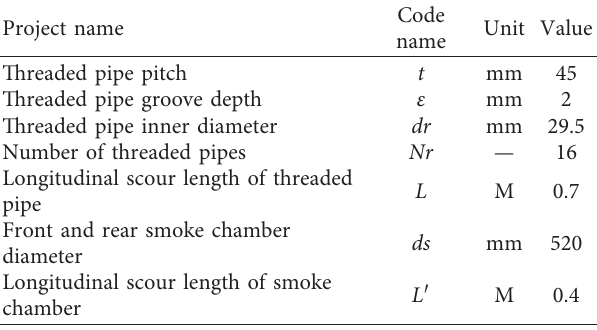
Table 5: Convection surface structure parameter table.